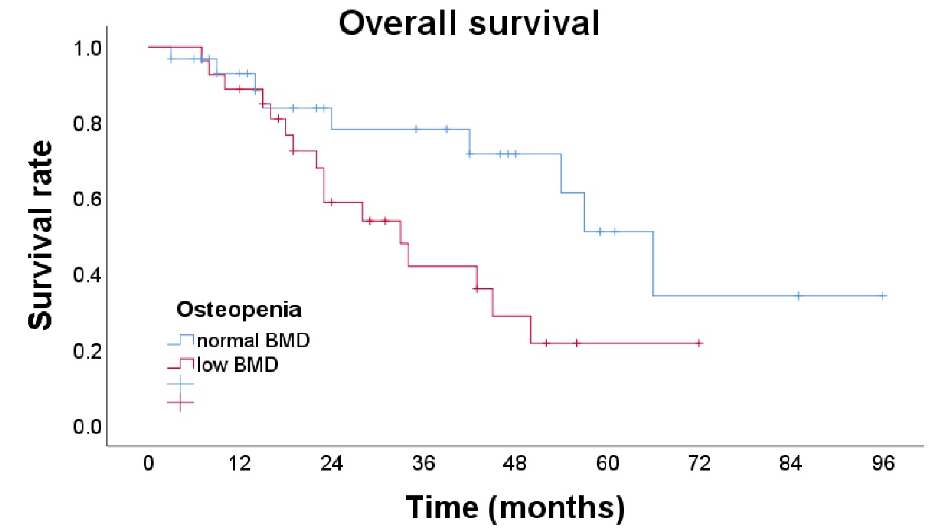
Figure 2. Overall survival of patients with and without osteopenia. The median survival of patients with osteopenia was 37 months and those without osteopenia had a significantly longer median survival of 61 months. Table 2. Univariate and multivariable analysis of factors associated with overall survival in patients with perihilar